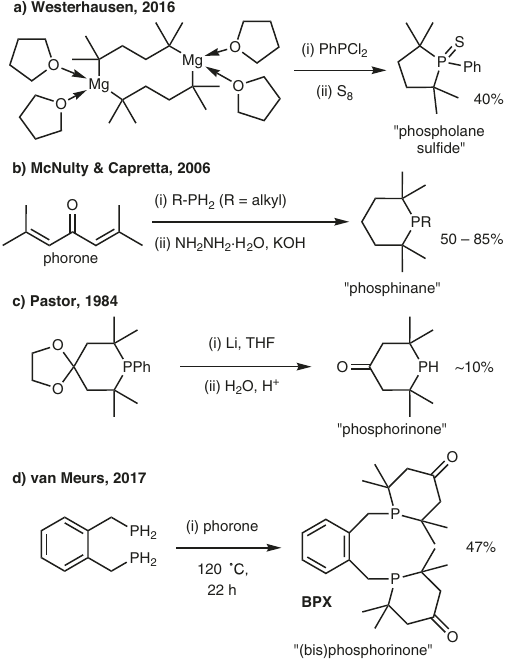
Fig. 2 Known bulky phospholanes and phosphinanes. a Phospholane sul fi de, b phosphinanes, c phosphorinones, d bis(phosphorinone) xylene,